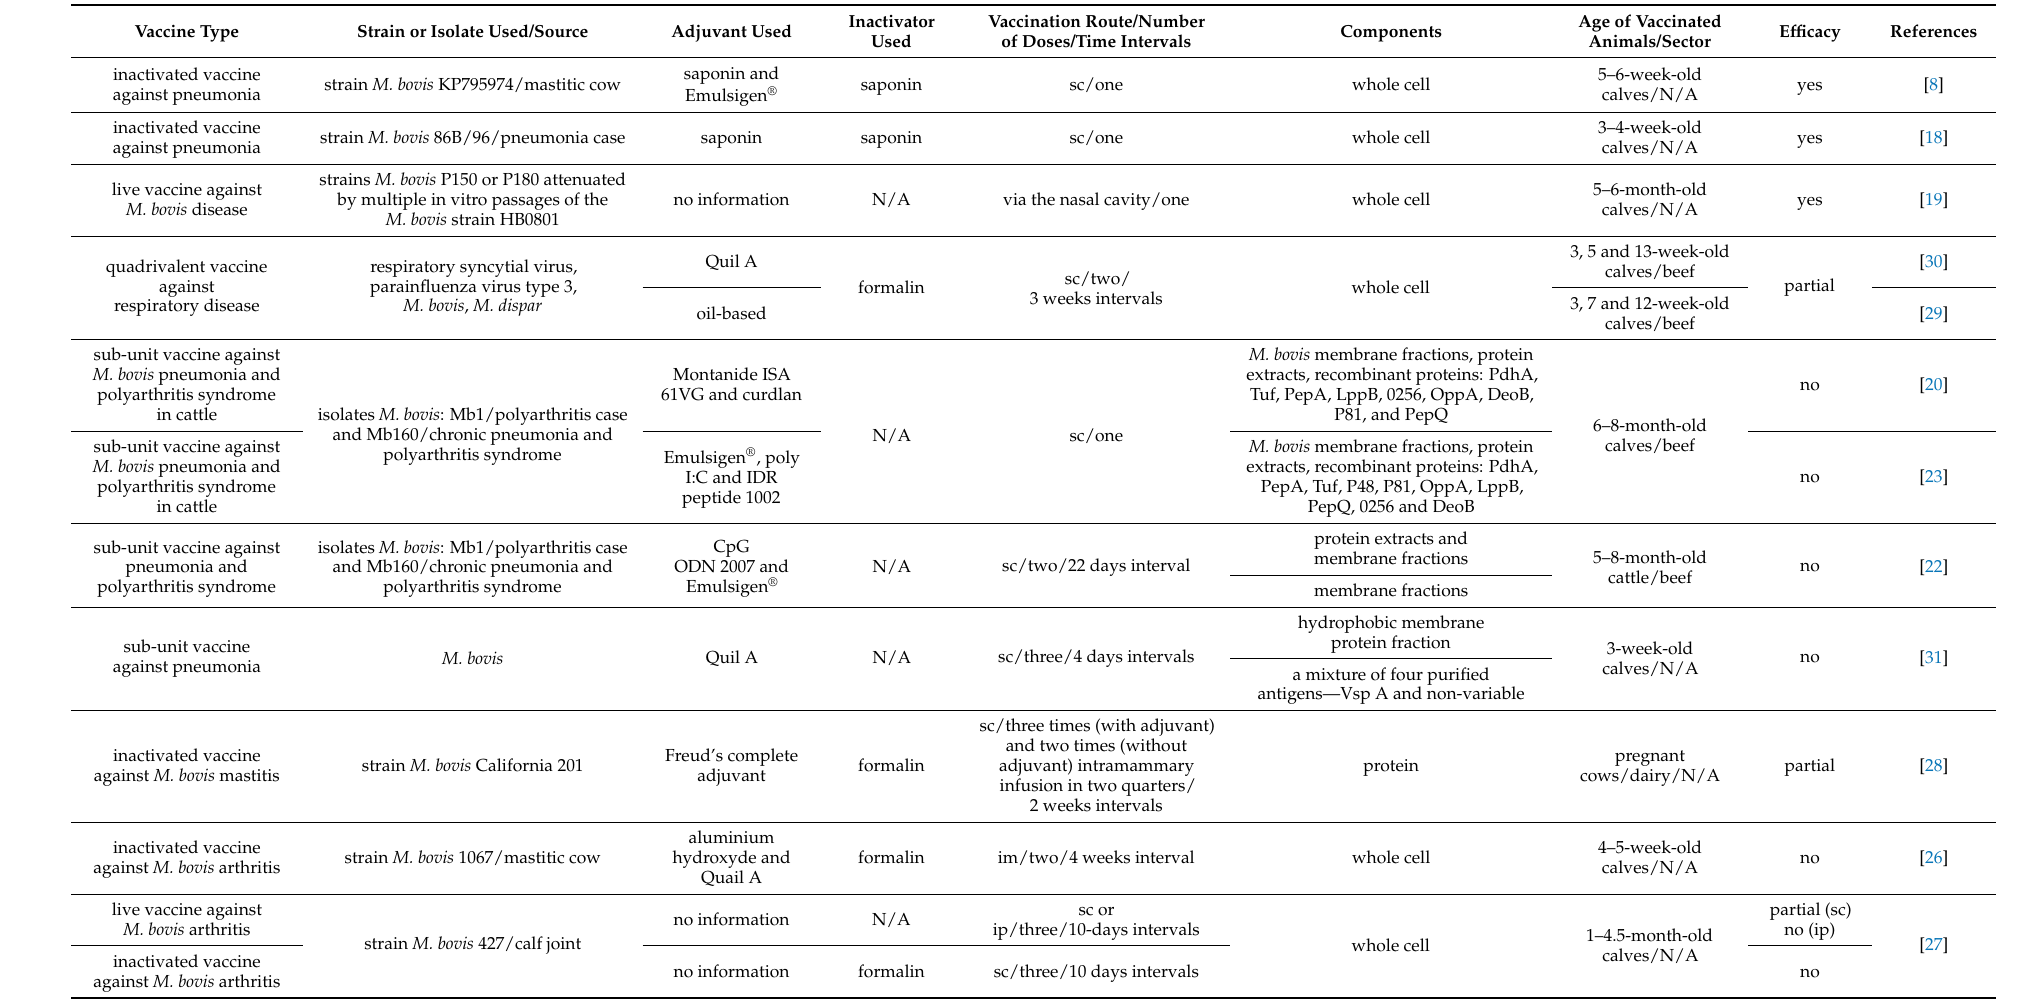
Table 1. Reported experimental vaccines against diseases caused by M. bovis